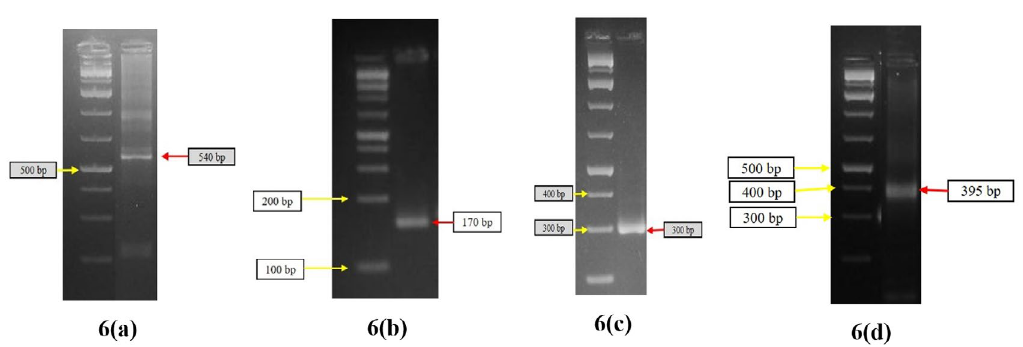
Fig. 6. Gel doc images of ars operon components. arsB (6a), arsC (6b) and arsR (6c) forms main component of ars operon. Fig 6(d) is gel doc image of aox operon component aoxB. The aox operon has two components aoxA and aoxB, aoxB is responsible for transformation of arsenite to